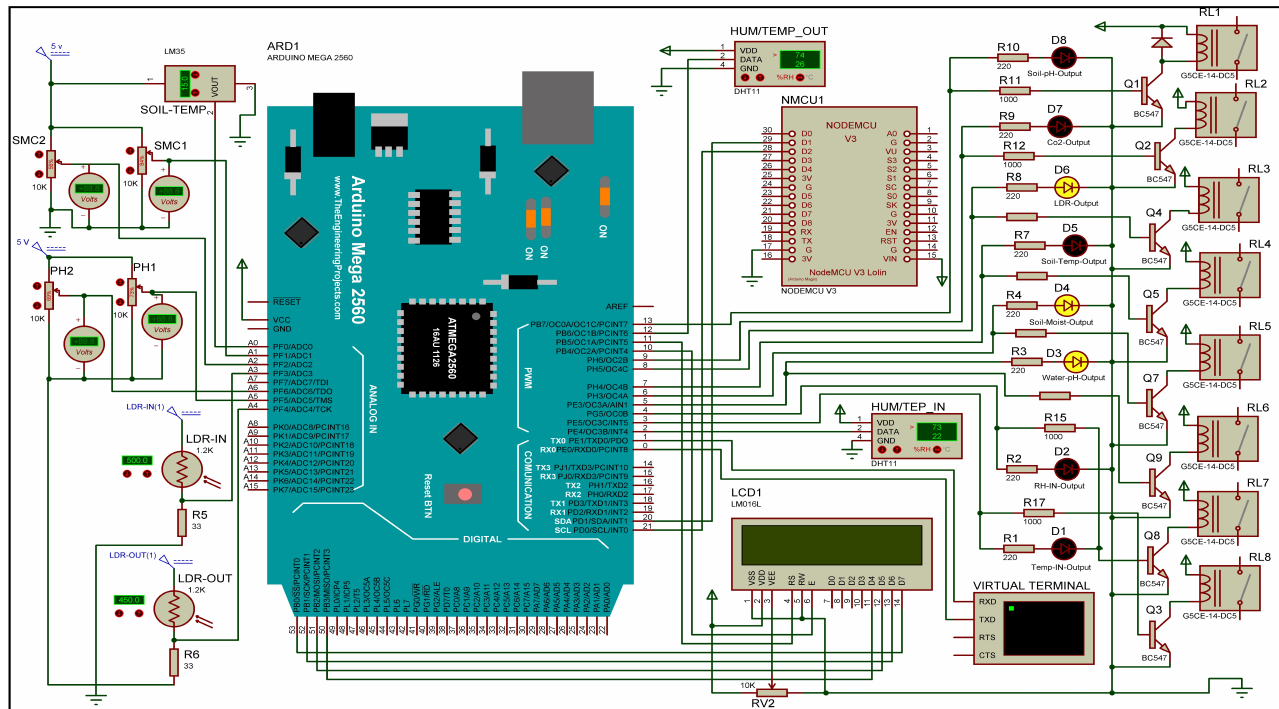
Figure 4. The schematic Proteus simulation